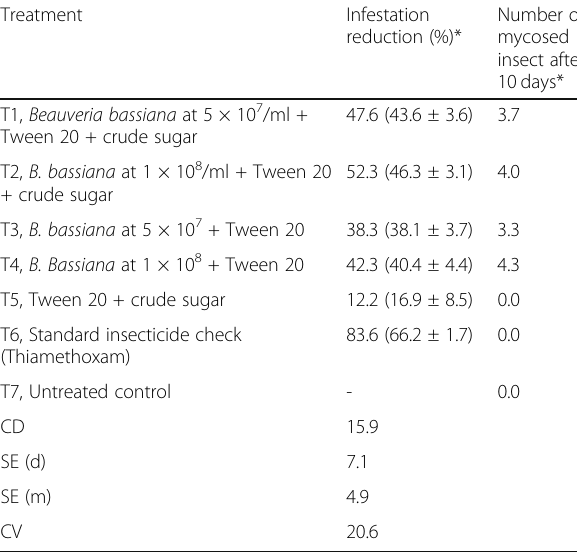
Table 5 In vivo evaluation of Beauveria bassiana in different combination of adjuvants